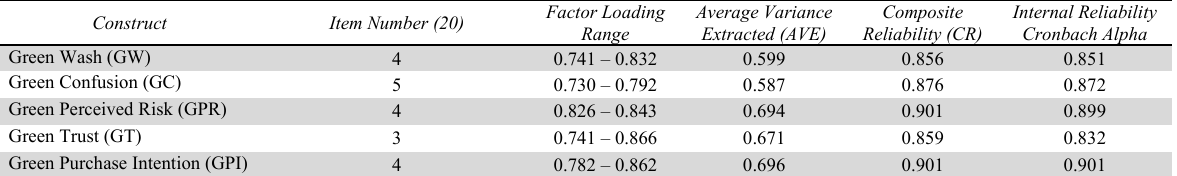
Internal Reliability and Convergent Validity